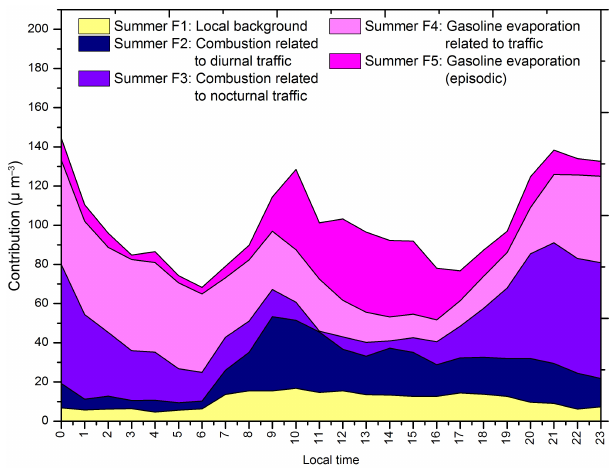
Figure 8. Diurnal variation of sources contribution (µgm − 3 ) in summer 2011 (local